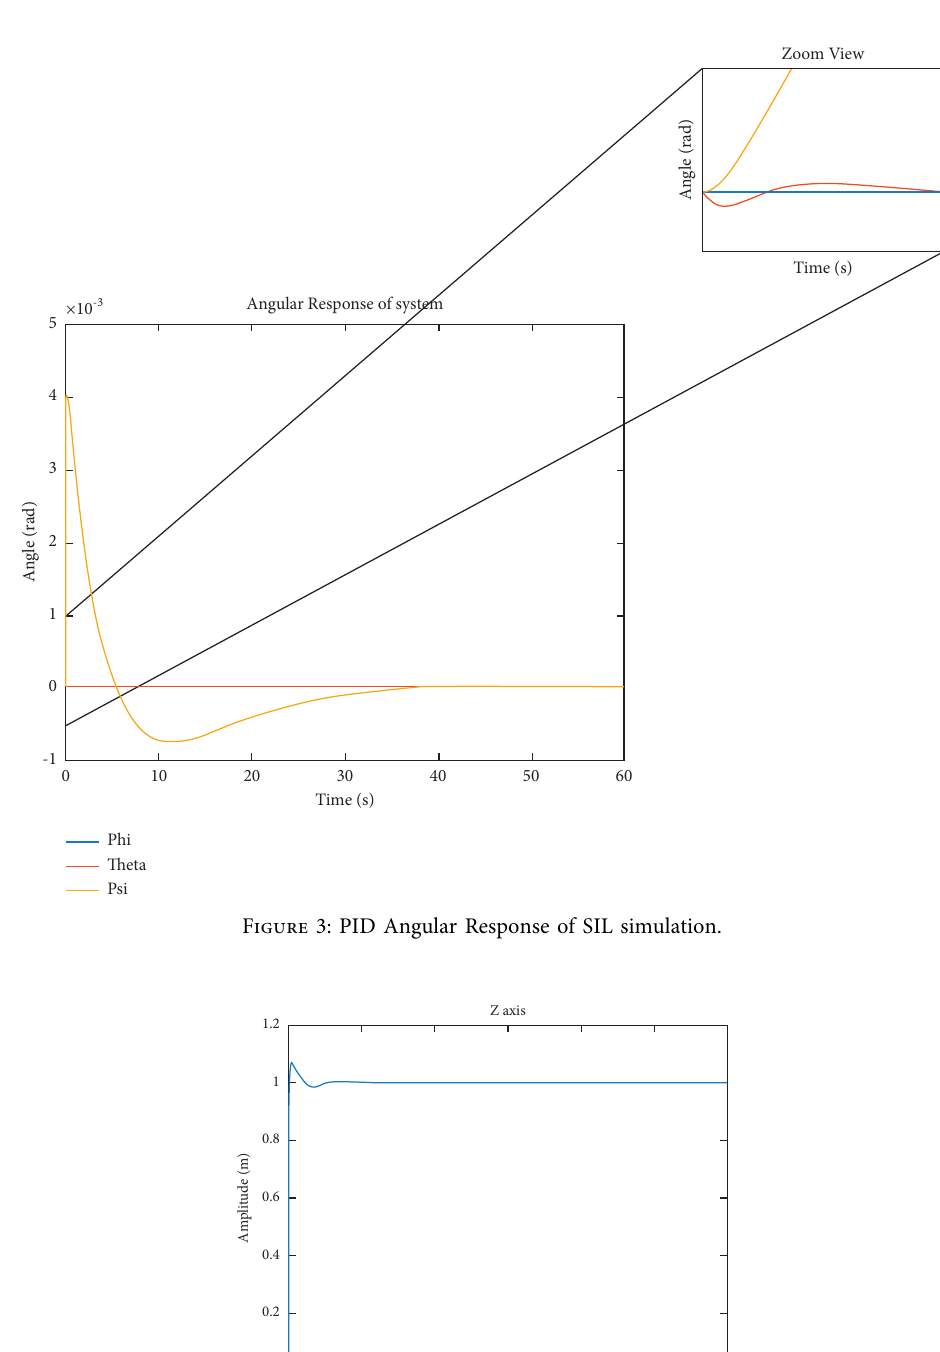
Figure 4: PID Altitude Response of SIL